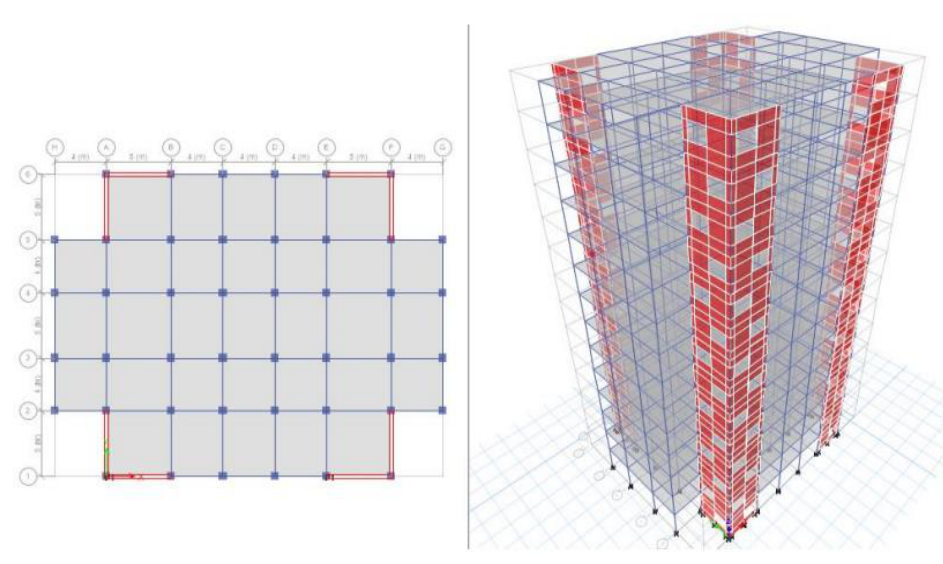
Figure 4. The geometry of the structure and 3D structure shear walls with staggered openings.